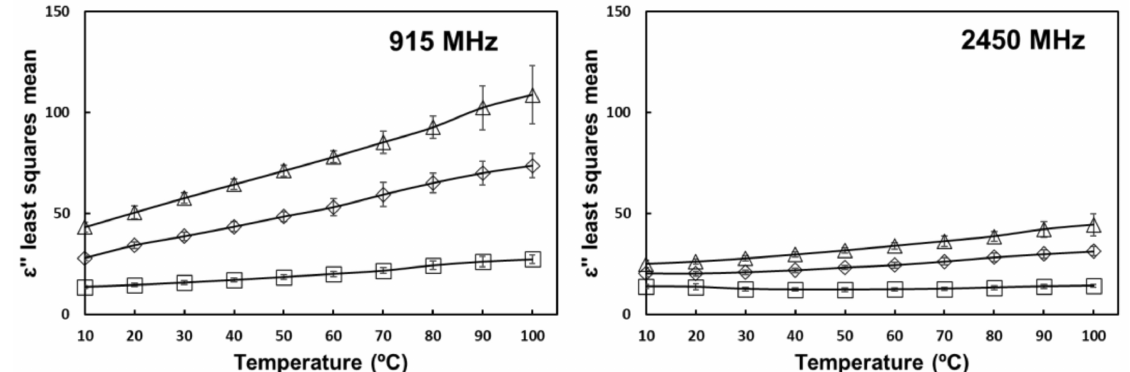
Figure 7. Temperature and salt interaction effect on the loss factor of tomato homogenate at 915 and 2450 MHz. ( ) 0% salt ( ) 0.5% salt ( ) 1% salt. Error bars correspond to standard